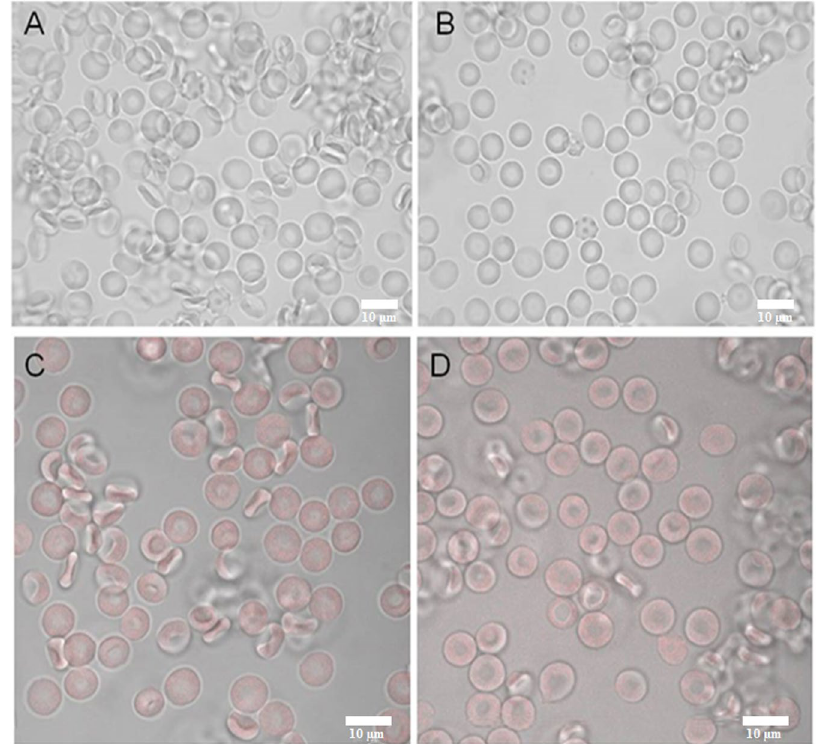
Figure 6. The effect of h-BN-OH on RBC morphology (1 hour at 37 °C) as observed with light microscopy: ( A ) control cells (PBS buffer) and ( B ) cells incubated with h-BN-OH-n (10 − 7 g/ml). The binding effect of Alexa Fluor 647-h-BN-OH-n on RBCs as observed by confocal microscopy: ( C ) control cell (PBS buffer) and ( D ) cells incubated with h-BN-OH-n (10 − 7 g/ml). Scale bars: 10 µ m.